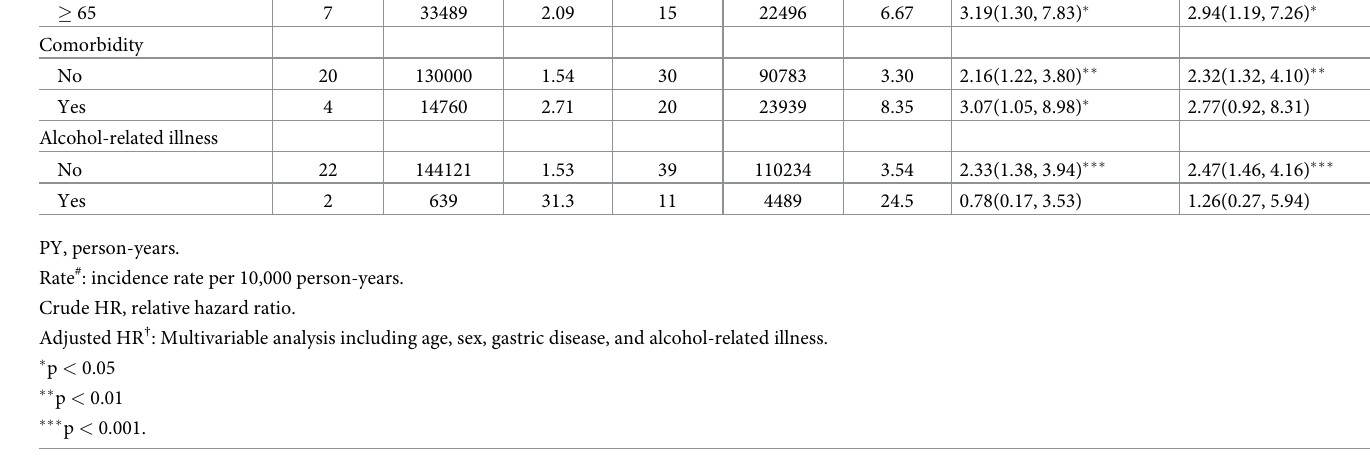
PY, person-years.